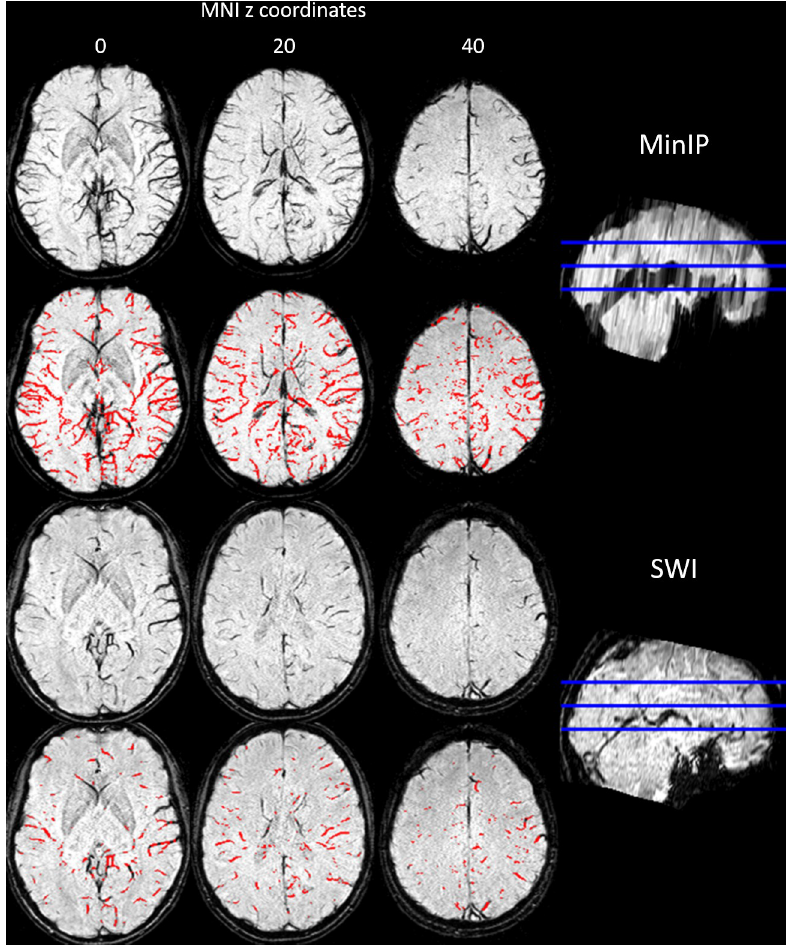
Table 2. Crosstabs table of 41 patients for whom headache symptoms were recorded upon presentation to the emergency room. Values represent number of patients.